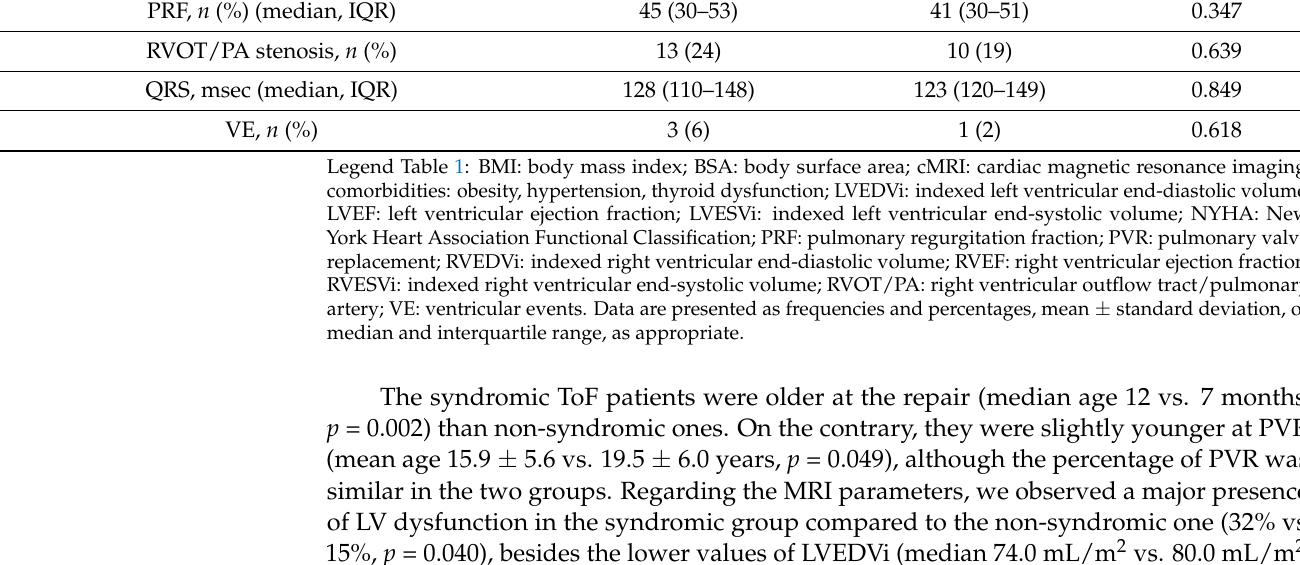
Legend Table 1: BMI: body mass index; BSA: body surface area; cMRI: cardiac magnetic resonance imaging; comorbidities: obesity, hypertension, thyroid dysfunction; LVEDVi: indexed left ventricular end-diastolic volume; LVEF: left ventricular ejection fraction; LVESVi: indexed left ventricular end-systolic volume; NYHA: New York Heart Association Functional Classification; PRF: pulmonary regurgitation fraction; PVR: pulmonary valve replacement; RVEDVi: indexed right ventricular end-diastolic volume; RVEF: right ventricular ejection fraction; RVESVi: indexed right ventricular end-systolic volume; RVOT/PA: right ventricular outflow tract/pulmonary artery; VE: ventricular events. Data are presented as frequencies and percentages, mean ± standard deviation, or median and interquartile range, as appropriate. The syndromic ToF patients were older at the repair (median age 12 vs. 7 months; p = 0.002) than non-syndromic ones. On the contrary, they were slightly younger at